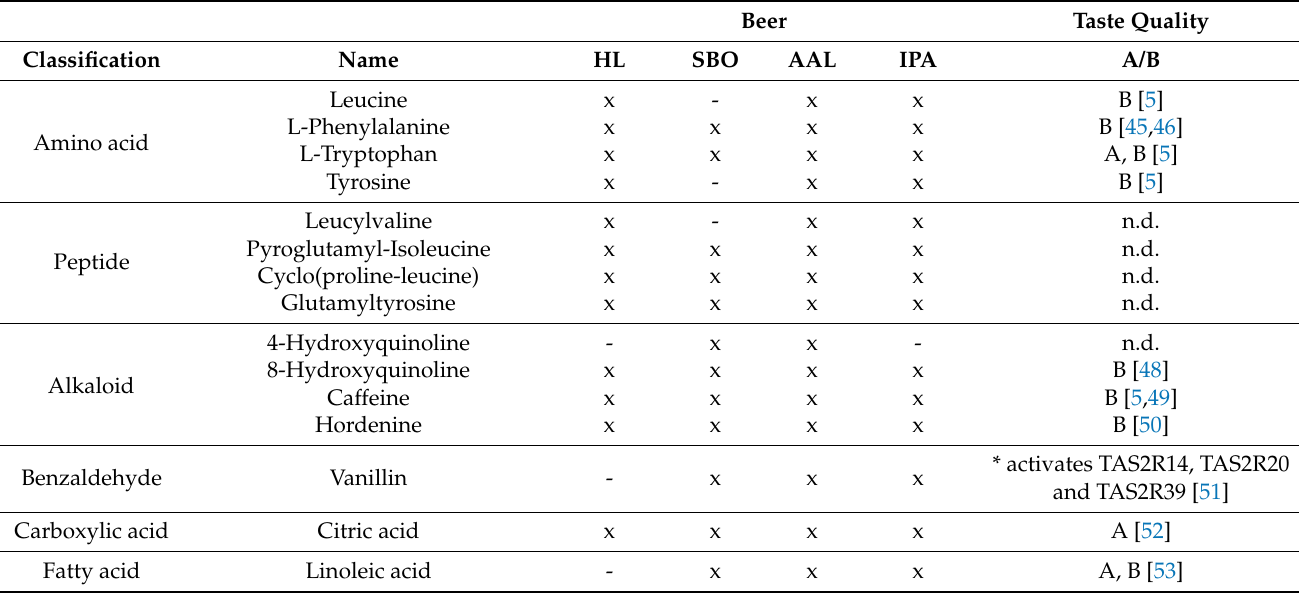
Table 4. Nonphenolic compounds present in the studied beers and their taste quality description. “A/B” description indicates astringency (A) and bitterness (B)